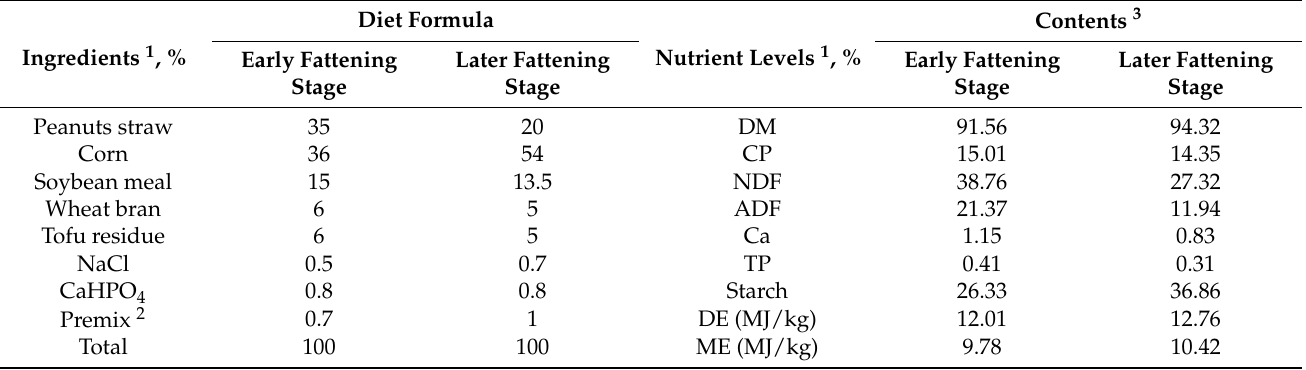
Table 1. Ingredients and chemical composition of the basal diets for the fattening sheep (%, DM basis).